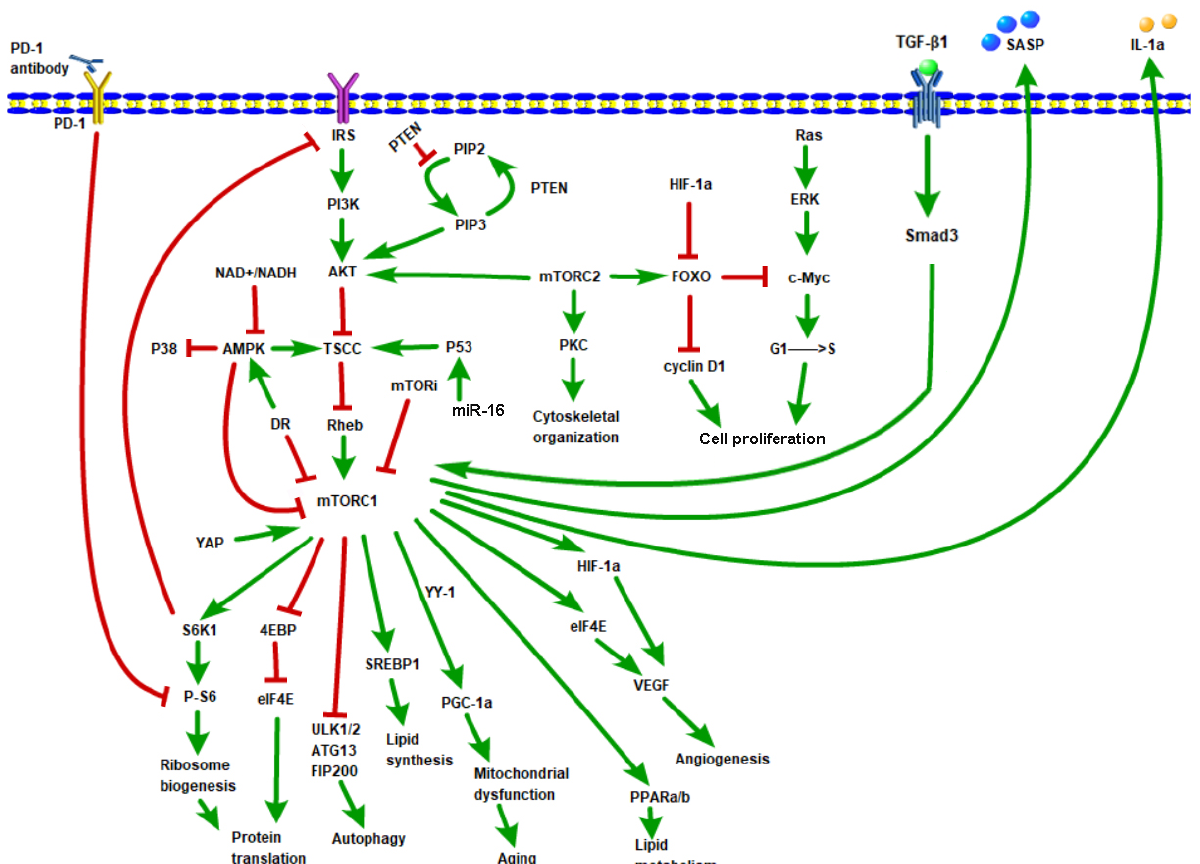
Figure 2. An overview of mTOR pathway. Green arrow means promoting effect, red T-shaped line represents the inhibitory effect. Table 1. Clinical investigations evaluating the efficacy of mTOR inhibitors in a combination for the treatment of HNSCC.